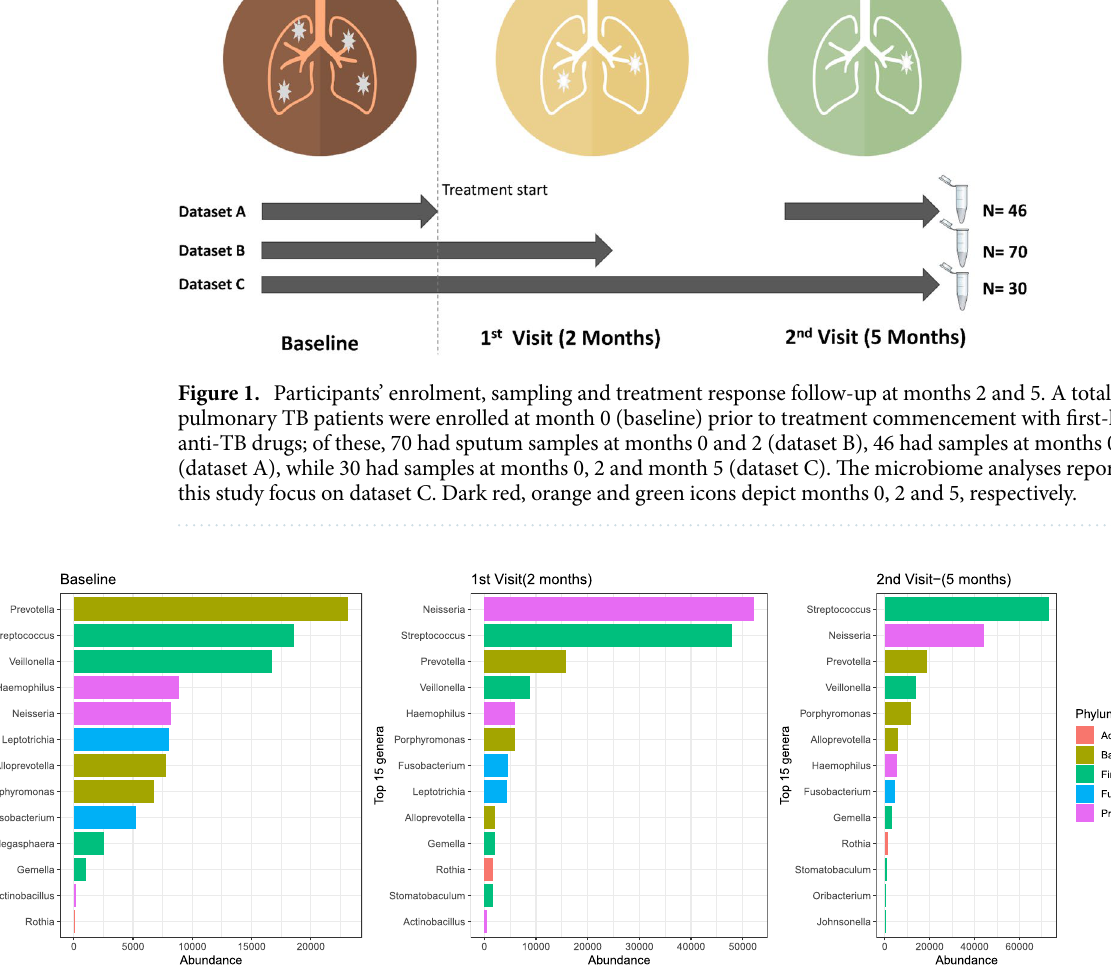
Figure 2. The 15 major bacterial genera detected across the three-sampling